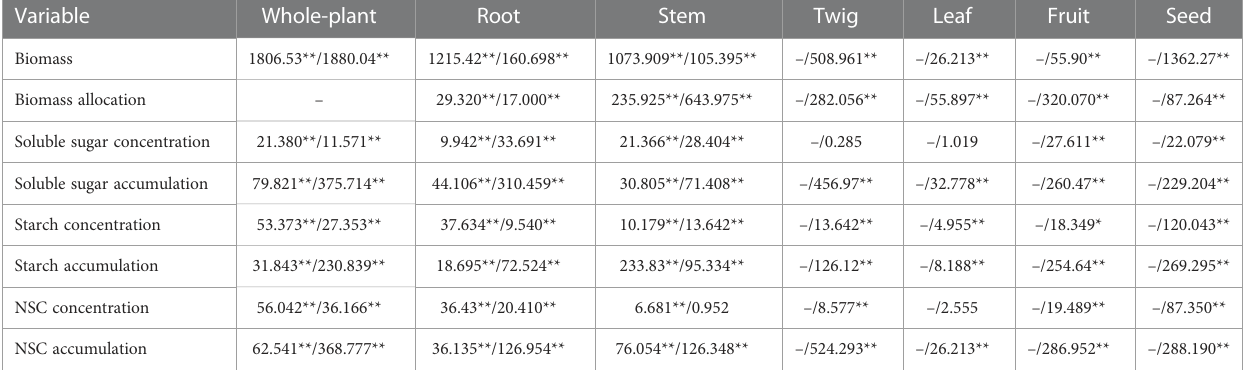
TABLE 1 F -values of One-way ANOVA for the effects of tree age (df=5) on the biomass, biomass allocation, the concentrations and accumulations of soluble sugar, starch, and NSC in each organ and whole-plant of Fengdan during dormancy/fruit ripening.